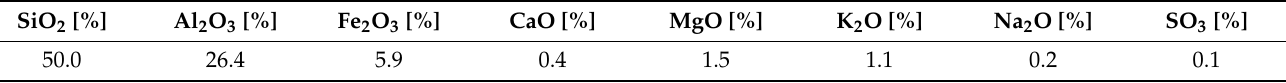
Table 3. Chemical composition of used HFA.